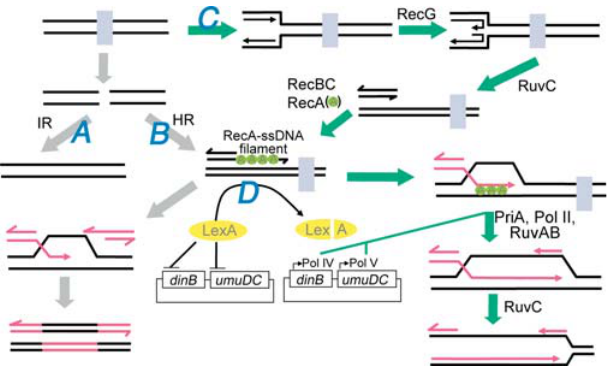
Figure 3. Proposed Response to